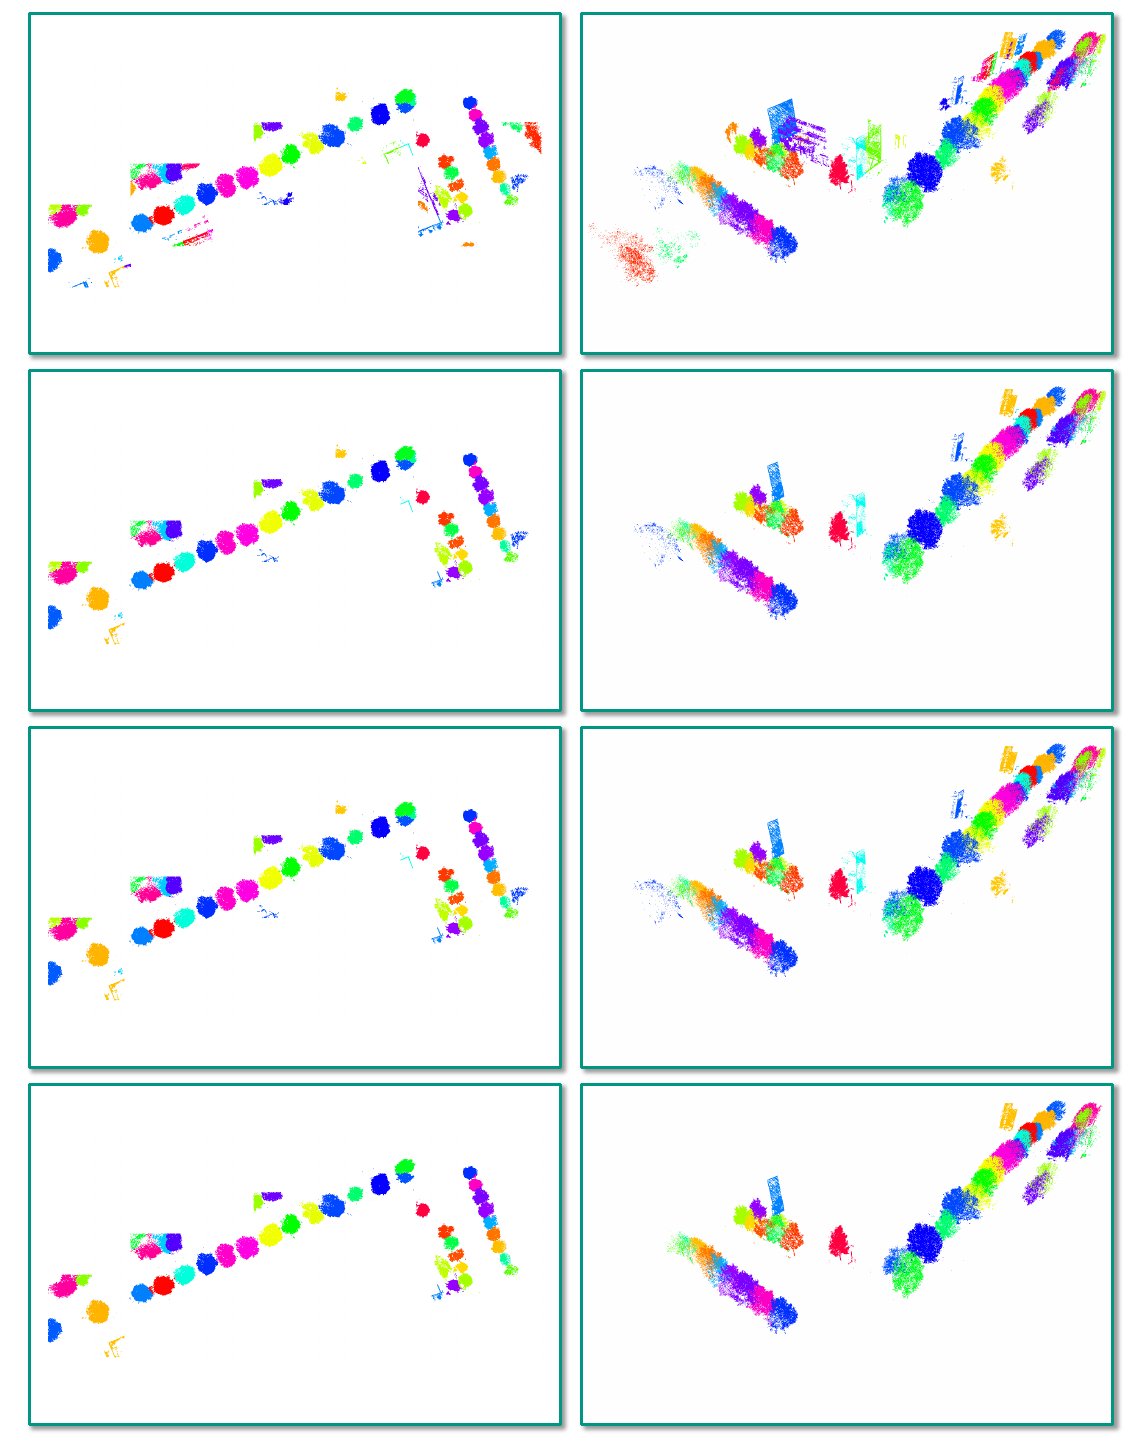
Figure 10. Segment-based shape analysis corresponding to the segmentation depicted in Figure 6 and relying on a classification based on the feature set S FCBF ( left : nadir view; right : side view): segments with N s ≥ 1000 points (first row) and segments that additionally satisfy the constraints R s Σ s ≥ 1 m for j = 1,2 (third row) and C (second row), ξ s j ξ